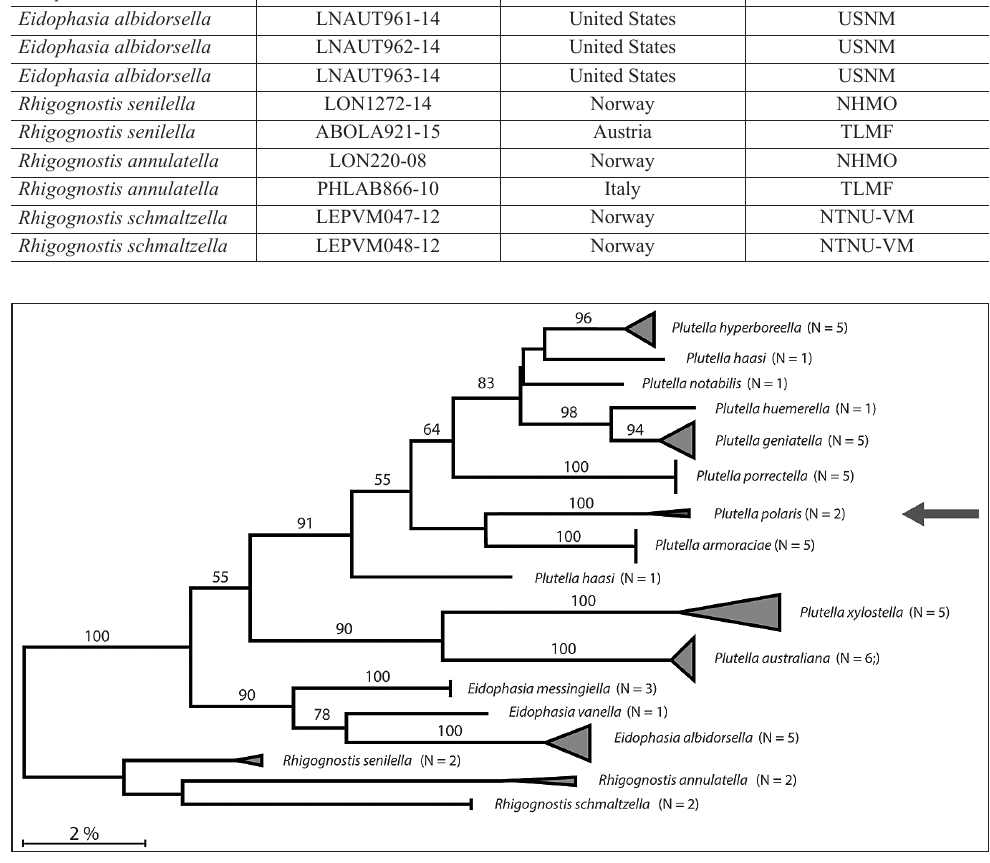
Figure 4. The Maximum Likelihood tree based on DNA barcoding of P. polaris (arrow) and 10 other nominal species in the genus Plutella . Six species representing the two genera Eidophasia and Rhigognostis were used as outgroup. Bootstrap support values (1000 replicates) are listed above the branches. Number of specimens is given in brackets after each